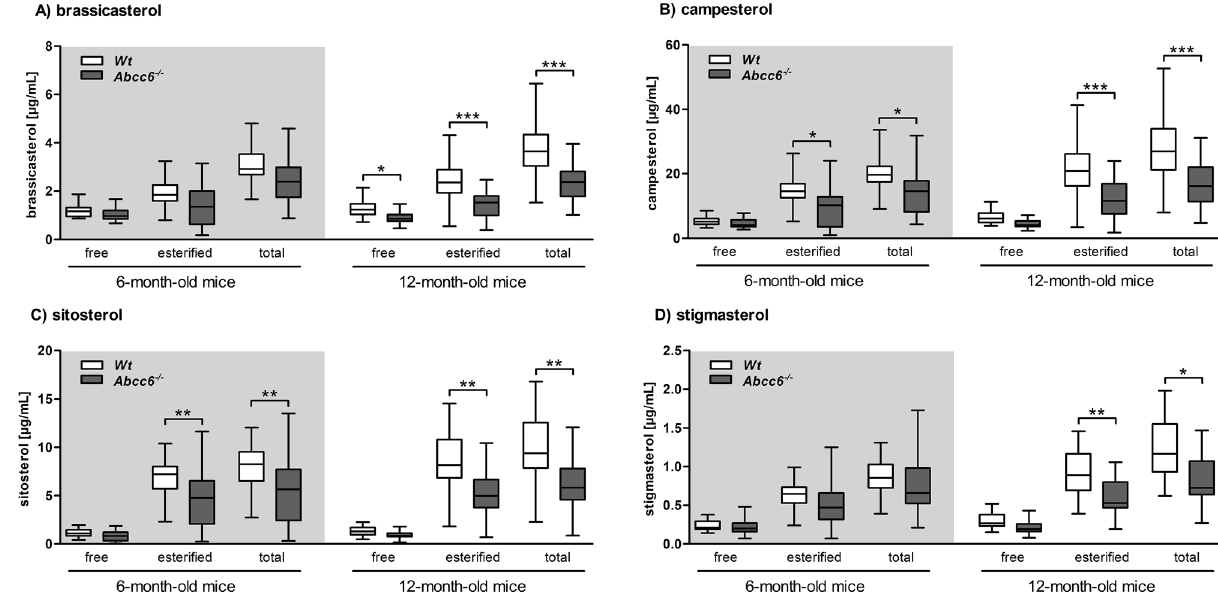
Figure 2. Reduced plant sterol levels in serum of Abcc6 knockout mice. Free, esterified and total phytosterol serum levels of WT and Abcc6 −/− mice (6-month-old: WT n = 28, Abcc6 −/− n = 19; 12-month-old: WT n = 41, Abcc6 −/− n = 40). ( A ) brassicasterol, ( B ) campesterol, ( C ) β-sitosterol and ( D ) stigmasterol. Data are mean ±